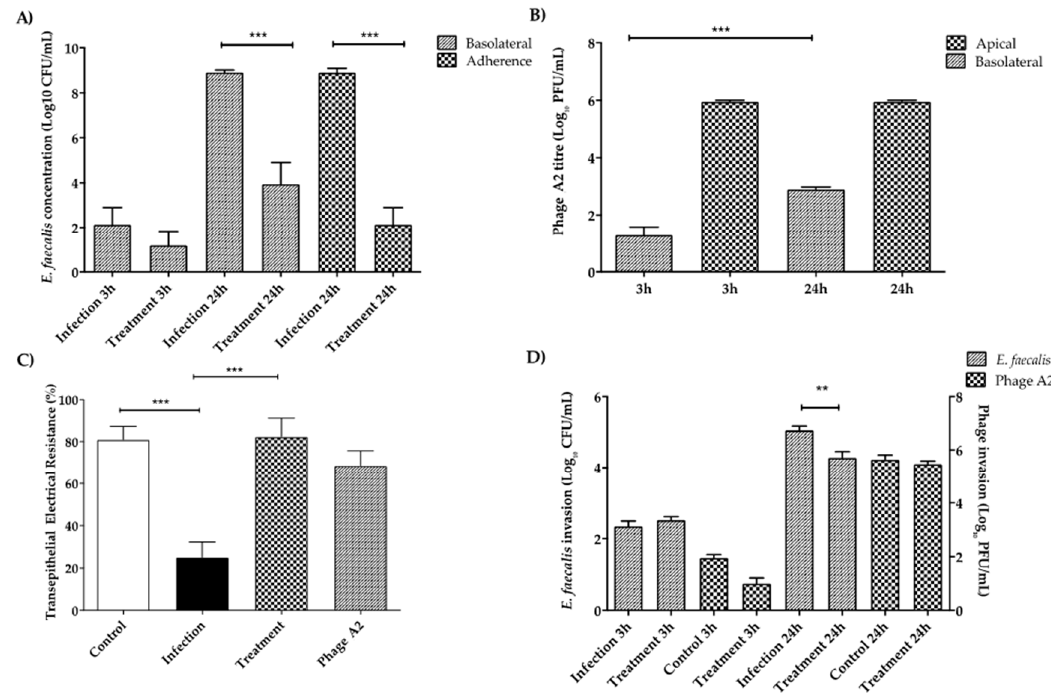
Figure 6. ( A ) E. faecalis adherence and translocation through intestinal epithelium and the effect of phage A2 predation. E. faecalis was left to adhere to the co-cultures for 3 h. At that point, treatment groups were inoculated with phage A2. ( B ) Enterococcus phage A2 translocation through intestinal epithelium when grown in trans-wells. Phage A2 was left to adhere to the co-cultures for 3 h. Then, fresh media was added to the wells without E. faecalis . ( C ) Co-culture trans-epithelial electrical resistance during exposure to E. faecalis and Enterococcus phage A2. E. faecalis was left to adhere to the co-cultures for 3 h. Treatment groups were inoculated with phage A2. The control and the phage groups were left uninfected with E. faecalis . ( D ) E. faecalis and phage A2 invasion of the intestinal epithelium. E. faecalis was left to adhere to the co-cultures for 3 h. At that point, the treatment groups were inoculated with phage A2. After 3 h or 24 h the samples were treated for 2 h with penicillin G to remove all the extracellular E. faecalis . Phage controls were not infected with E. faecalis , these groups were used to check phage invasion without the host. Columns show average concentration ( n = 9) ± standard error. ** p < 0.01; *** p < 0.001.